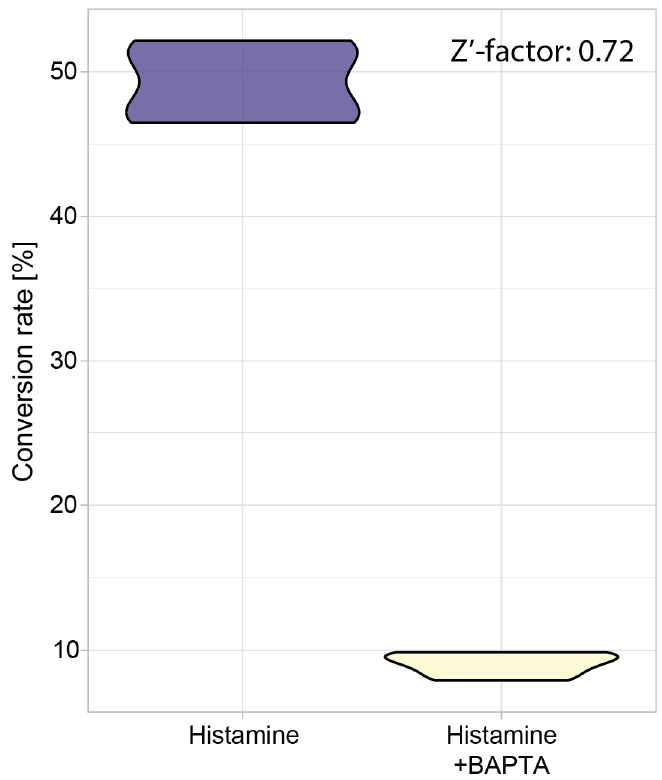
Figure 8. Z’ ‐ Factor analysis based on all four parabolas of the first parabolic flight day. CaMPARI2 ‐ F391W transfected human C28/I2 chondrocytes were treated with 100 μ M histamine to induce photoconversion of CaMPARI2 ‐ F391W with 405 nm light. In addition, the Histamine + BAPTA condition was pretreated with 10 μ M of the calcium (Ca 2+ ) chelator BAPTA ‐ AM as a negative control. The calculated Z’ ‐ factor for the first flight day is 0.72.